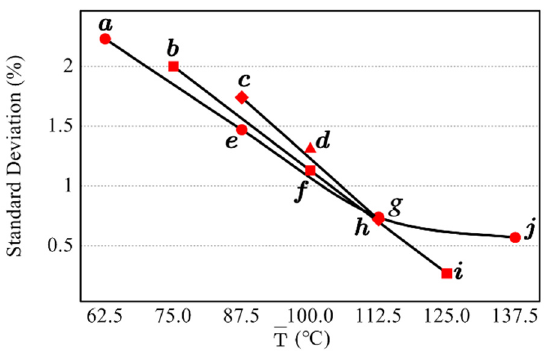
Figure 7. Relationship between average temperature and standard deviation for the ten irradiation combinations.